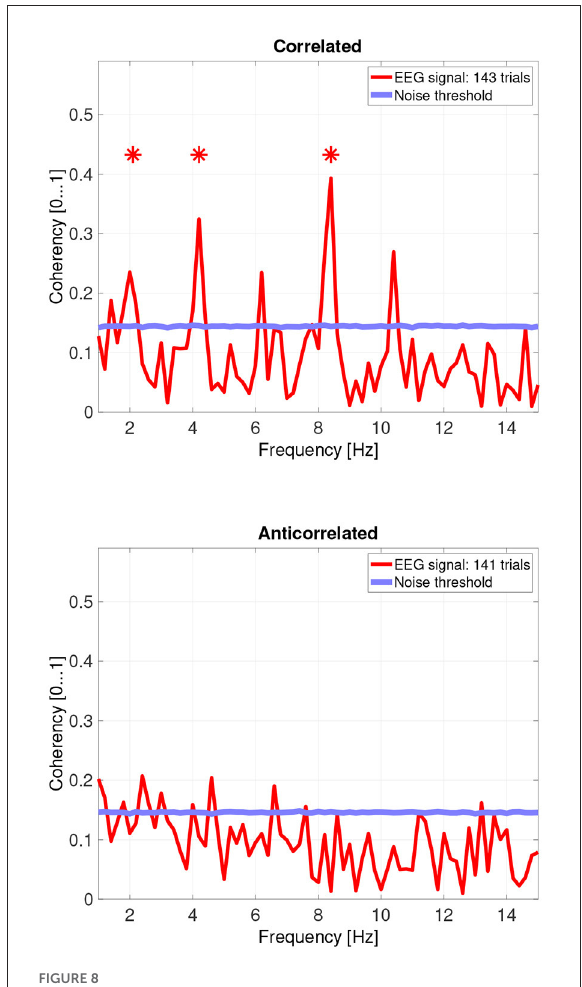
FIGURE8 Coherency values from participant AT. The stars above the peaks indicate successful detection of the harmonic of the stimulus frequency. Note that the coherency plots are in phase space, and that they are not showing spectrum: a higher coherency value imply a stronger relationship to the stimulus. The “Noise threshold” is created with 10,000 data sets having the same number of trials, with the trials containing only white noise. The line shows the 95 th percentile of the coherency values created from these synthetic data sets.